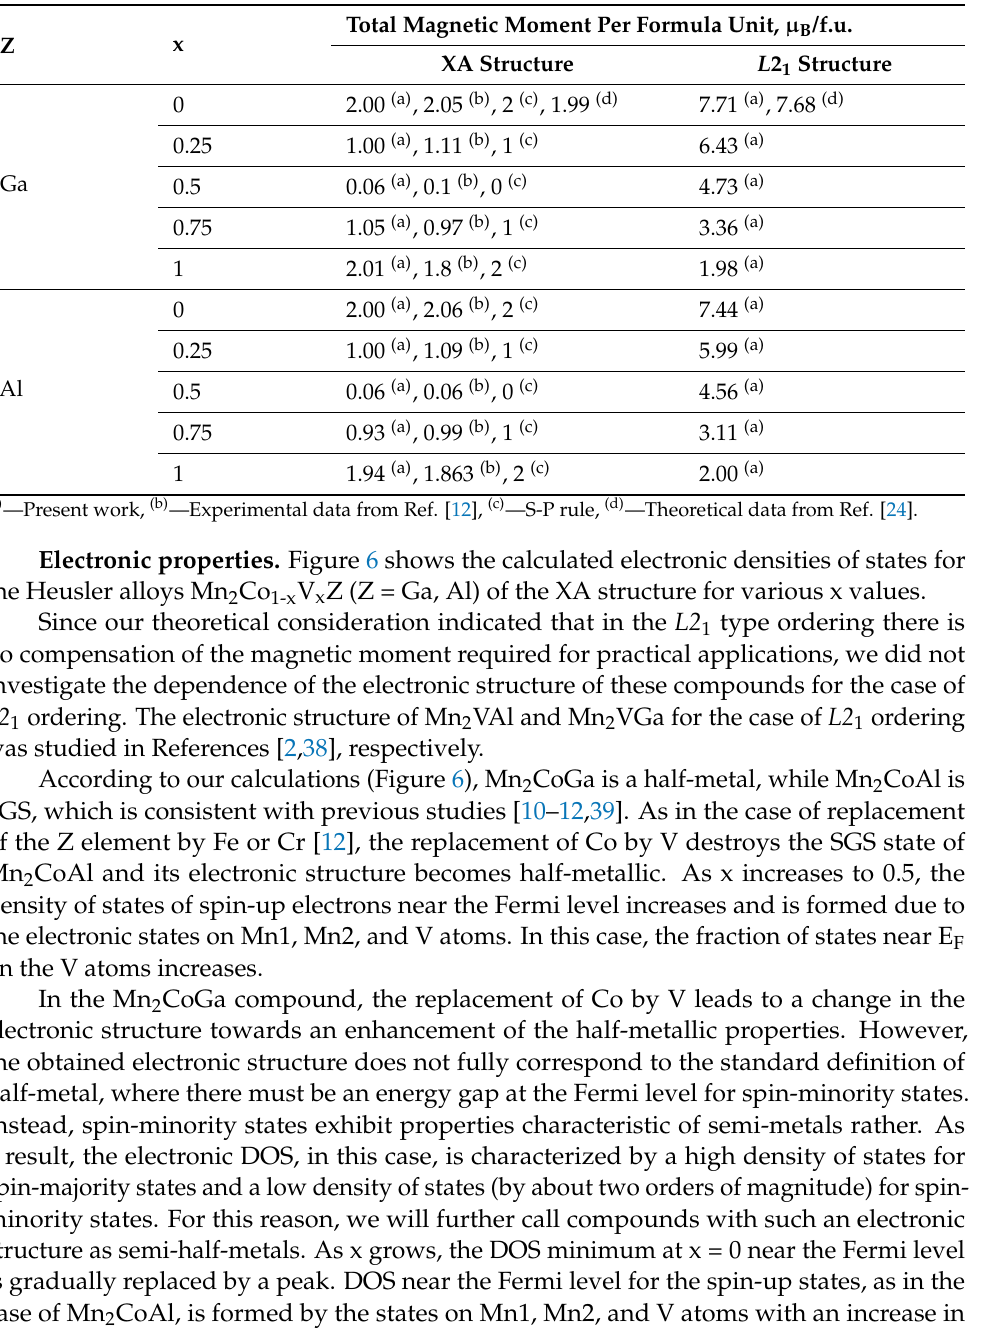
Table 2. Total magnetic moment calculated for the L2 1 and XA structures of the Mn 2 Co 1-x V x Z (Z = Al, Ga) Heusler